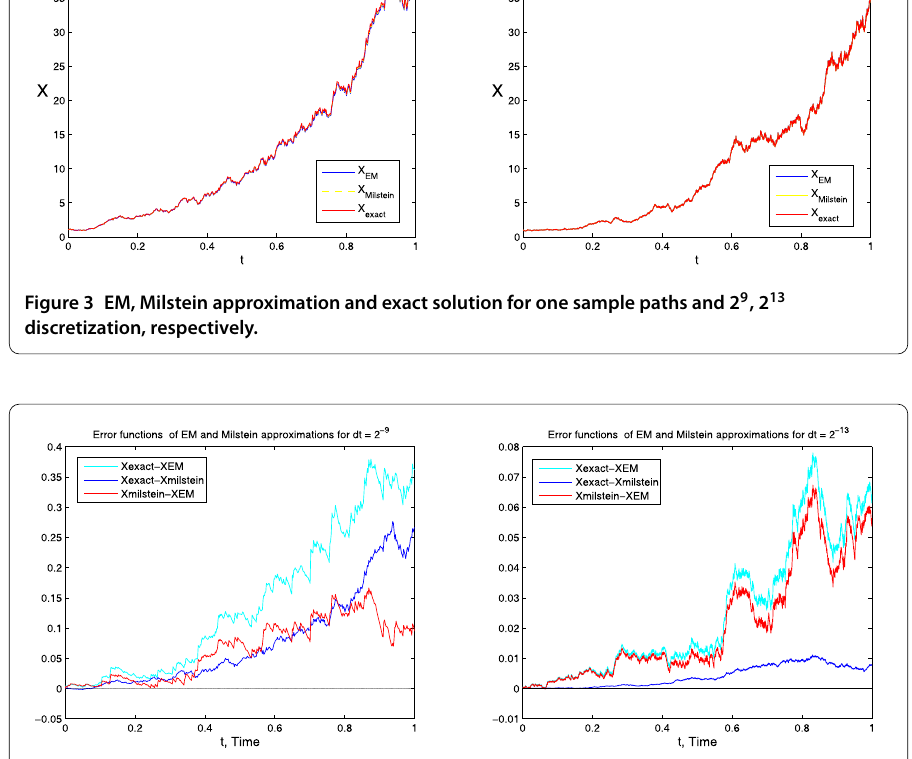
Figure 4 Error function between EM, Milstein approximation and exact solution for one sample paths and 2 9 , 2 13 discretization, respectively.